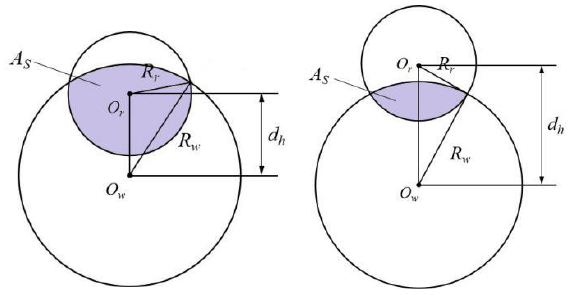
Figure 6. Two scenarios of wake overlap for a hilly WF.